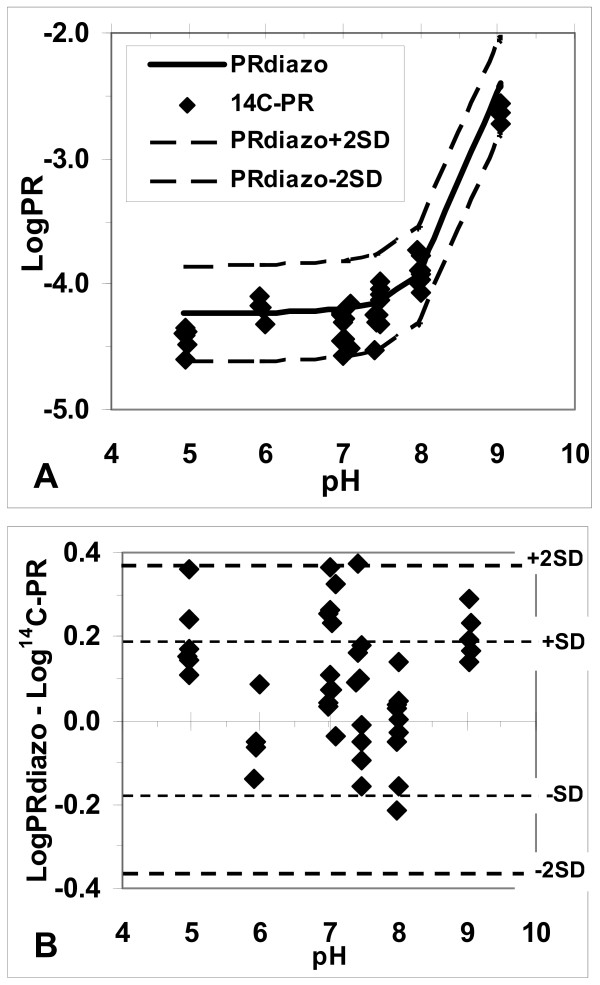
Comparison of aqueous:chloroform partition ratios of radioactivity (14C-PR, ◆), using 14C-UCB, with partition ratios of unlabeled UCB (PRdiazo). PRdiazo was calculated from the equation derived from diazo-assay of the two phases [3], plotted against pH of the aqueous buffer. Panel A – Log PR vs. pH. Heavy solid line shows the PRdiazo derived from computer modeling the diazo-based data [3]. Panel B – The same data, plotted as the difference, log PRdiazo – log 14C-PR. In each panel, the heavy dashed lines represent the 95% confidence limits of the log PRdiazo data, equal to 2 × 0.191, the [root mean sq. deviation]0.5 of the log PRdiazo data [3]. Only one of the 14C-PR data points (at pH 7.4) falls barely outside the 95% confidence limits for the PRdiazo data.